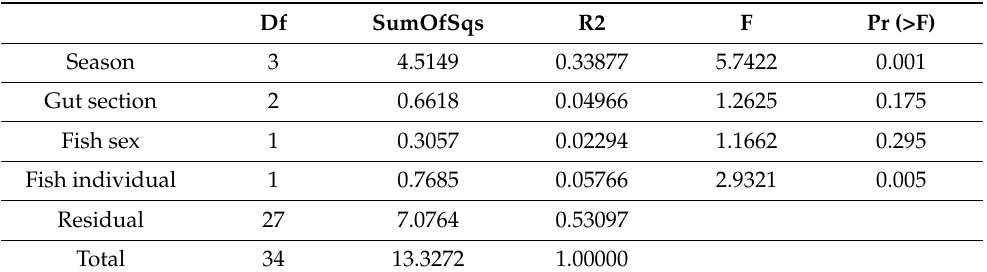
Table 1. Permutational multivariate analyses (PERMANOVA) testing variation in bacterial commu- nity composition explained by season (fall, winter, spring, and summer), gut microbiome section (stomach, cecum and intestine), fish sex (male or female), and fish individual.